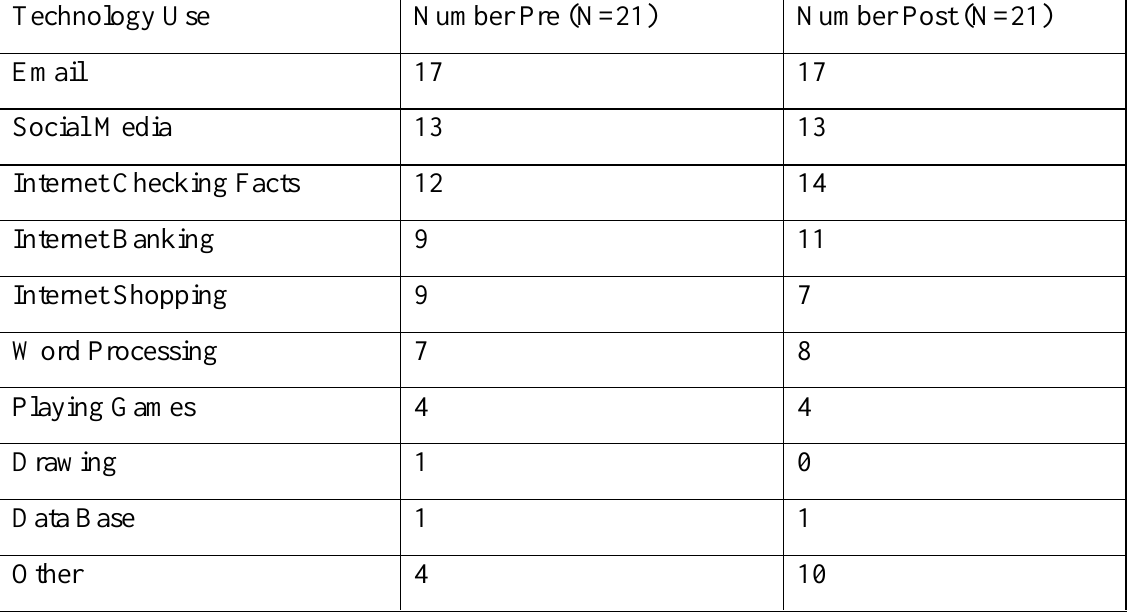
Table 3: Table of Technology Use Pre and Post Technology